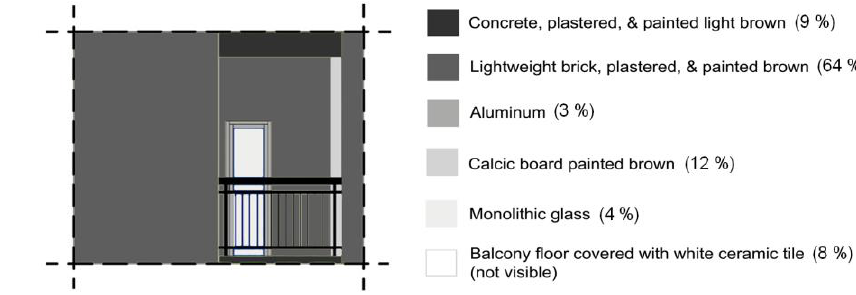
Fig. 4. Façade of apartment units with glass door in a small balcony (B apartment).